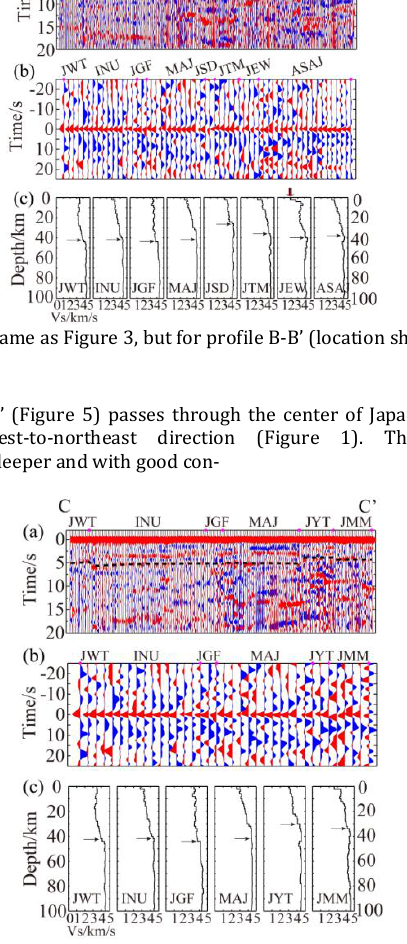
Figure 5: The same as Figure 3, but for profile C- C’ (location shown in Figure 1). sistence (42-44km) to the west of station MAJ, and shallower (30-34km) to the east of MAJ. An obvious positive phase (red color) at about 3-4 sec could be identified between station JWT to station MAJ from the PRF profile (Figure 5 (a)), which might be the conversion wave from Conrad interface. This phase could also be observed in west of Japan Islands (Figure 4 (a)), but couldn’t be found in the east of the Islands. (Figure 3 (a)). To further analyze the results, the S-wave velocity images at different depths from 0km to 100km with 5km or 10km interval were drawn by the two-dimensional in